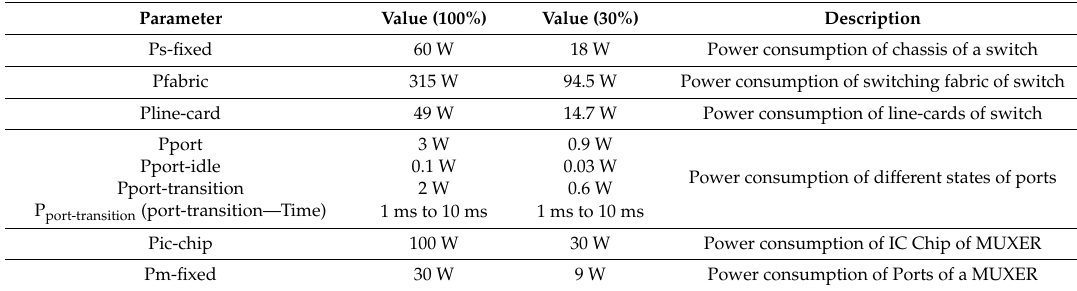
Table 2. Parameters are used in the models (Calculated with Cisco Power Calculator [18]). Value